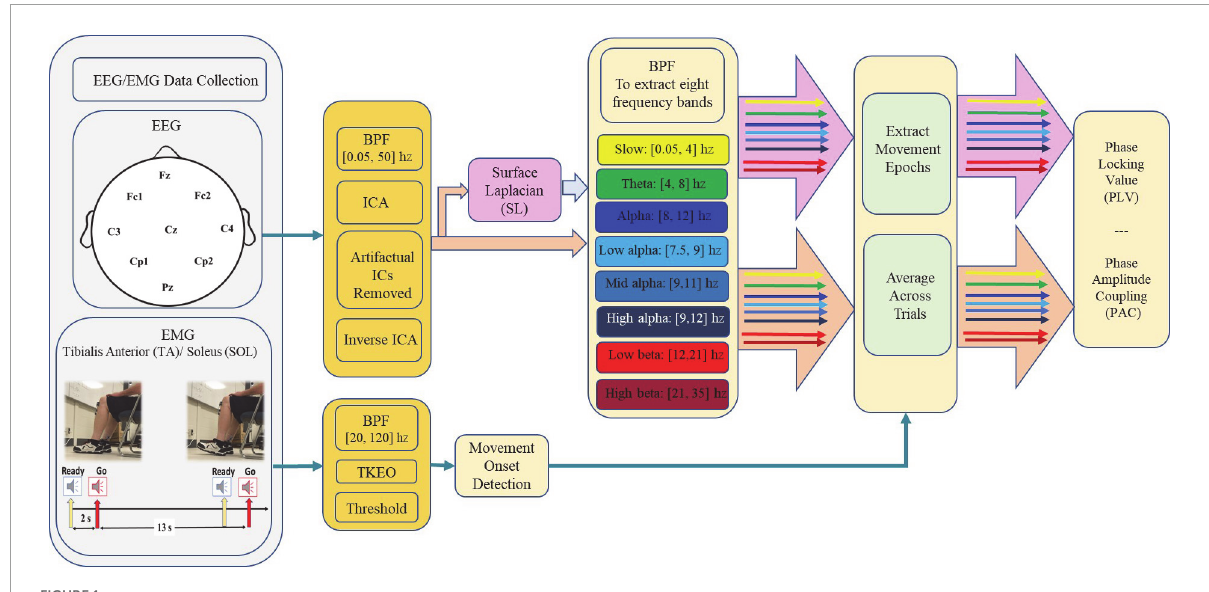
FIGURE1 Schematic representation of experimental setup and data processing.